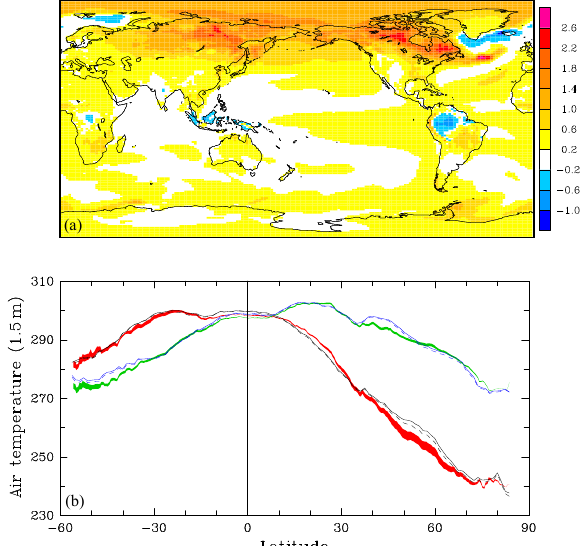
Figure 2. Surface air temperature difference (a) between ProgLAI and PresLAI for years 901–1000 and zonal mean land surface air temperature (b) for ProgLAI in January (black, solid) and July (blue, solid) and for PresLAI in January (black, dashed) and July (blue, dashed). The zonal mean ± SD 1901–1910 observed land sur- face air temperature (Jones and Harris, 2014) is shown by the red shaded region for January and the green shaded region for